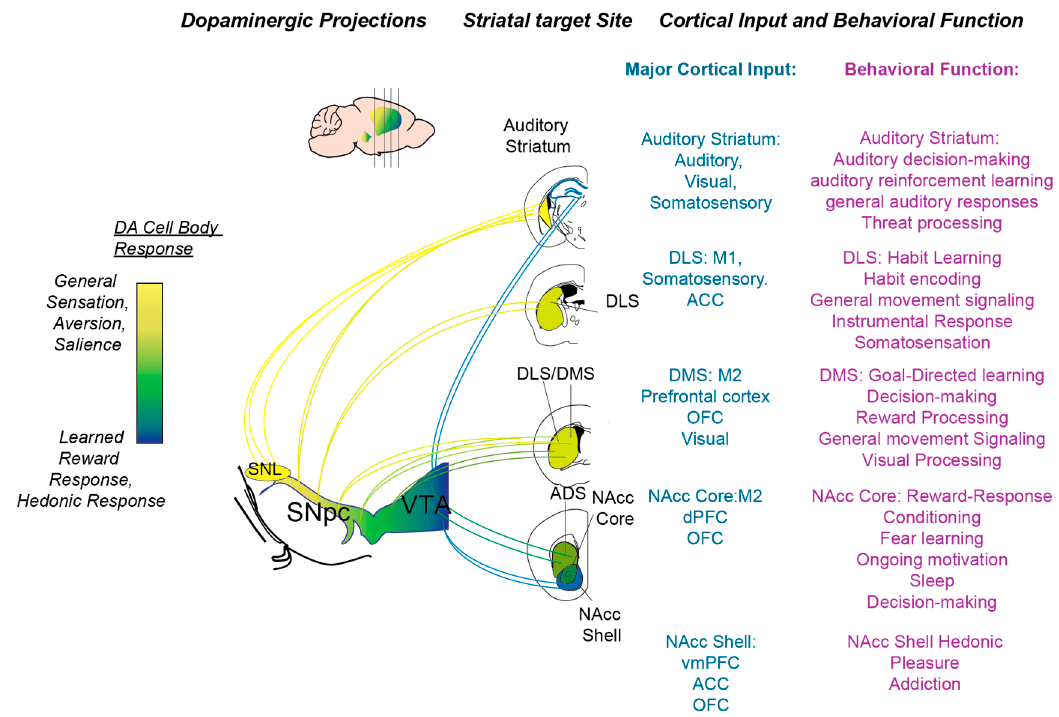
Figure 1. The medial–lateral midbrain projection system to the anterior–posterior striatal axis: Different regions of the dorsal striatum receive dopaminergic inputs from distinct but overlapping populations of the SNpc and the VTA. The posterior auditory striatum primarily receives nigrostriatal input from the lateral portions of the SNpc or what has been termed the substantia nigra pars lateralis (SNL). Moving anteriorly, there is relatively more contribution from the medial portions of the SNpc, and then subsequently contributions from the VTA. On the opposite end of the spectrum, the NAcc ventral striatum receives input primarily from the VTA, with lateral portions of the VTA projecting to the NAcc core and medial portions projecting to the shell. Major input across the posterior to anterior dorsal striatum/NAcc gradually shifts from sensory to limbic cortices. Here, we listed the differential inputs and associated behavioral functions of each subregion. Abbreviations: Dopamine, DA; dorsolateral striatum, DLS; dorsomedial striatum, DMS; nucleus accumbens, NAcc; primary motor cortex, M1; anterior cingulate cortex, ACC; orbitofrontal cortex, OFC; secondary motor cortex, M2; dorsal prefrontal cortex, dPFC; ventromedial prefrontal cortex, vmPFC.